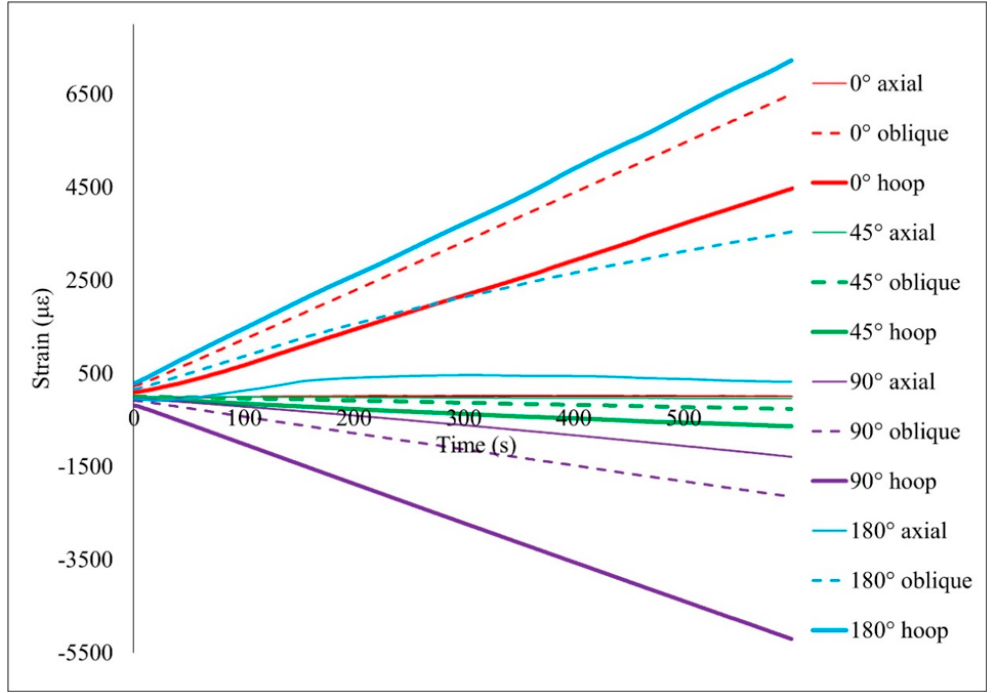
Figure 13. A typical strain-time curve for the plain type of DN500.